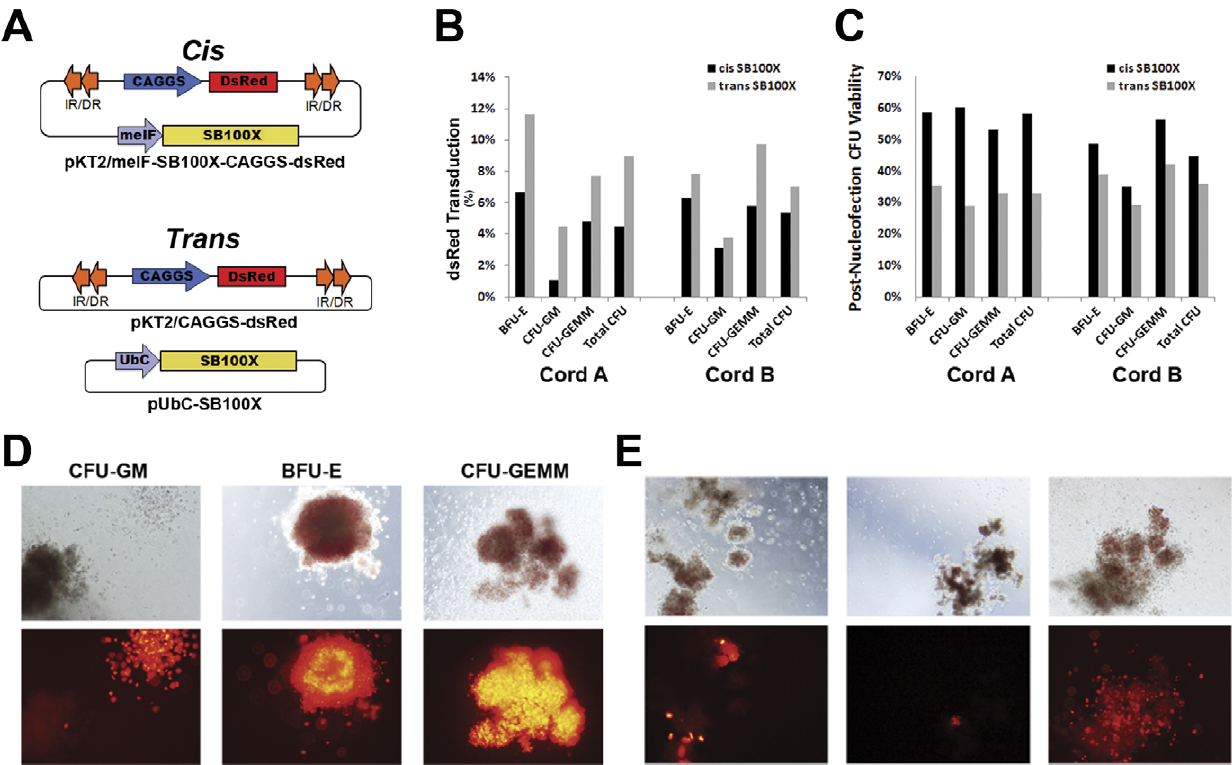
Figure 1. SB 100X Transduction of CD34 + cells in cis and trans configurations. ( A ) Schematics of cis and trans Sleeping Beauty plasmid vectors (not to scale). ( B ) Percentage of DsRed + CFUs in cis or trans . ( C ) Colony Forming Units (CFU) derived from CD34 + cells nucleofected with 10 m g of cis pKT2-meIF- SB 100X-CAGGS-DsRed or 10 m g of trans pKT2/CAGGS-DsRed and 5 m g of UbC- SB 100X using split cell samples. Totals from 4 replicates per vector per cord were normalized to non-nucleofected CFU output to give CFU viability. ( D ) Colonies were scored by standard light microscopy (150 6 magnification) for CFU type (top row) and epifluorescence microscopy for DsRed expression (bottom row). DsRed + cells were found among CFU-GM (left panels), BFU-E (center panels), and CFU-GEMM (right panels). Cis constructs shown. ( E ) DsRed + colonies were not homogeneous in expression patterns suggesting position effect variegation and epigenetic changes after transgene integration.